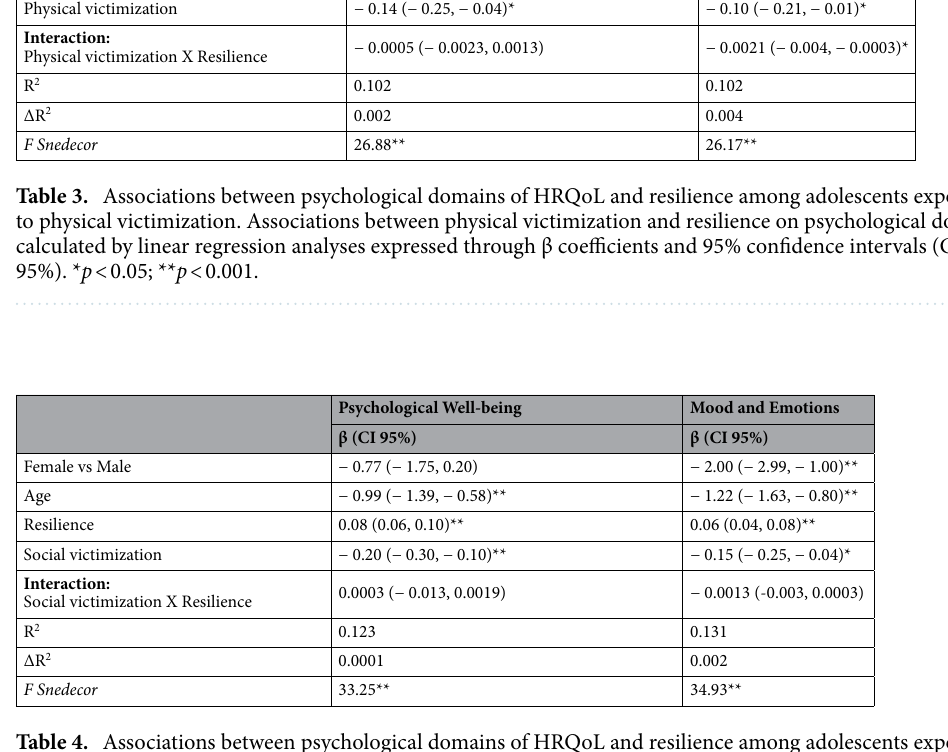
Table 4. Associations between psychological domains of HRQoL and resilience among adolescents exposed to social victimization. Associations between social victimization and resilience on psychological domains calculated by linear regression analyses expressed through β coefficients and 95% confidence intervals (CI 95%). * p < 0.05; ** p < 0.001.